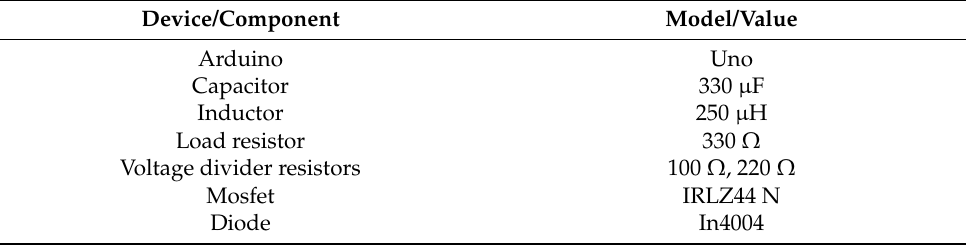
Table 2. Hardware